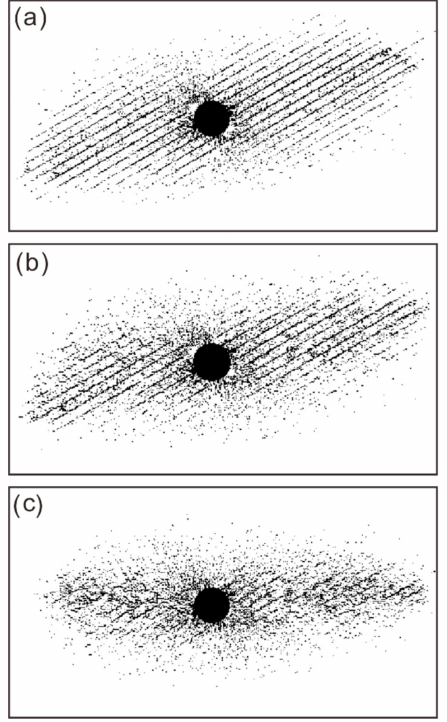
Figure 12. Distribution of the fractures for compressive strengths of 100 ( a ), 150 ( b ), and 200 MPa ( c ) for a structural plane orientation of 30 ◦ . The boundary stress and injection rate were the same as for the base